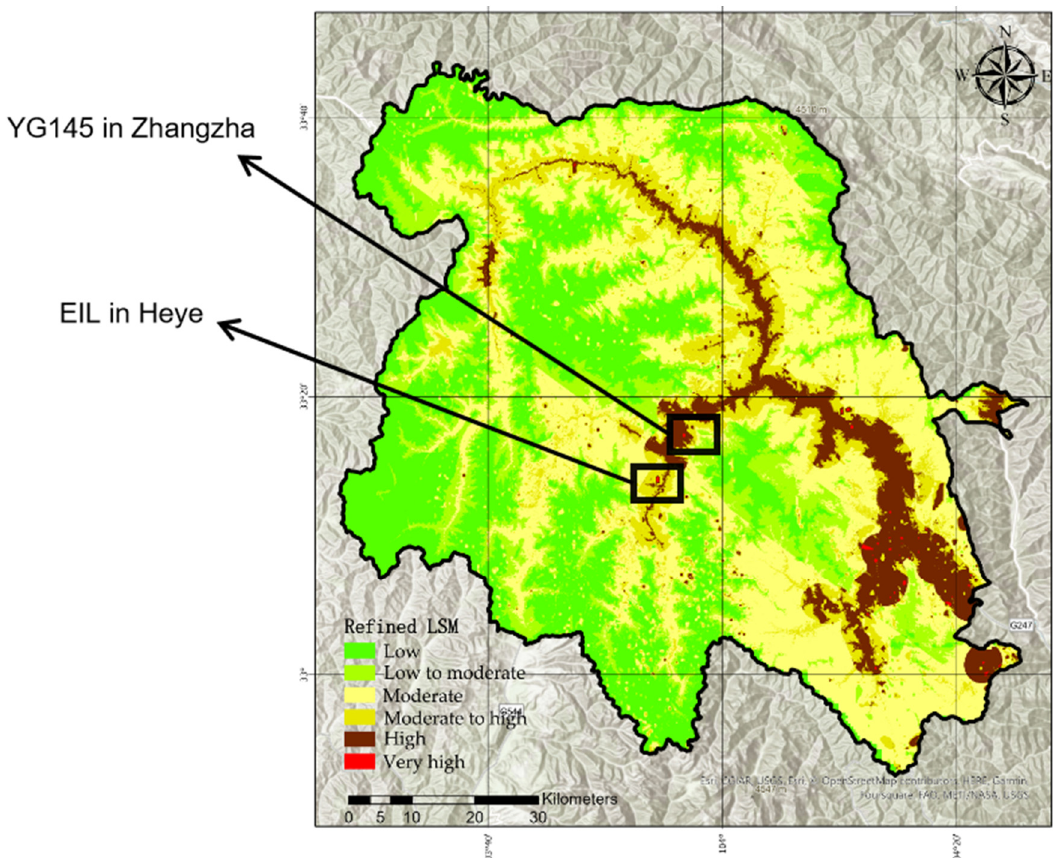
Figure 12. The refined LSM using the InSAR result, and very high susceptibility areas (rank 6) are added to illustrate major focus areas. Black polygons indicate sites where deformation acceleration events were still being recorded; Figure 14 shows a detailed ground survey of each site with photographs.